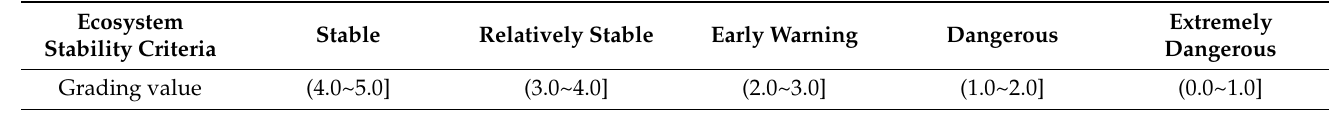
Table 1. Ecosystem stability evaluation grades. Ecosystem Stability Criteria